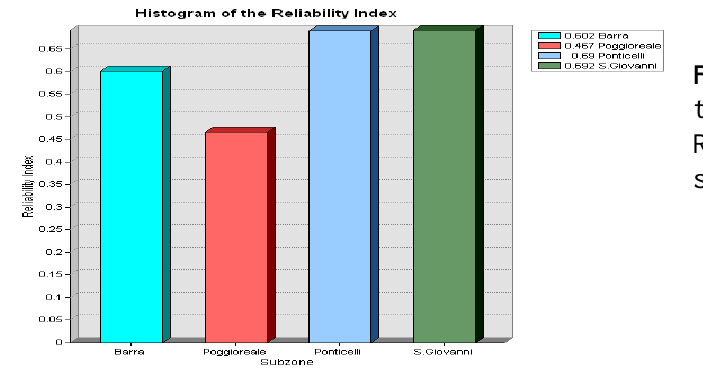
Fig. 7. Histogram of the reliability index Rel(O) for the four